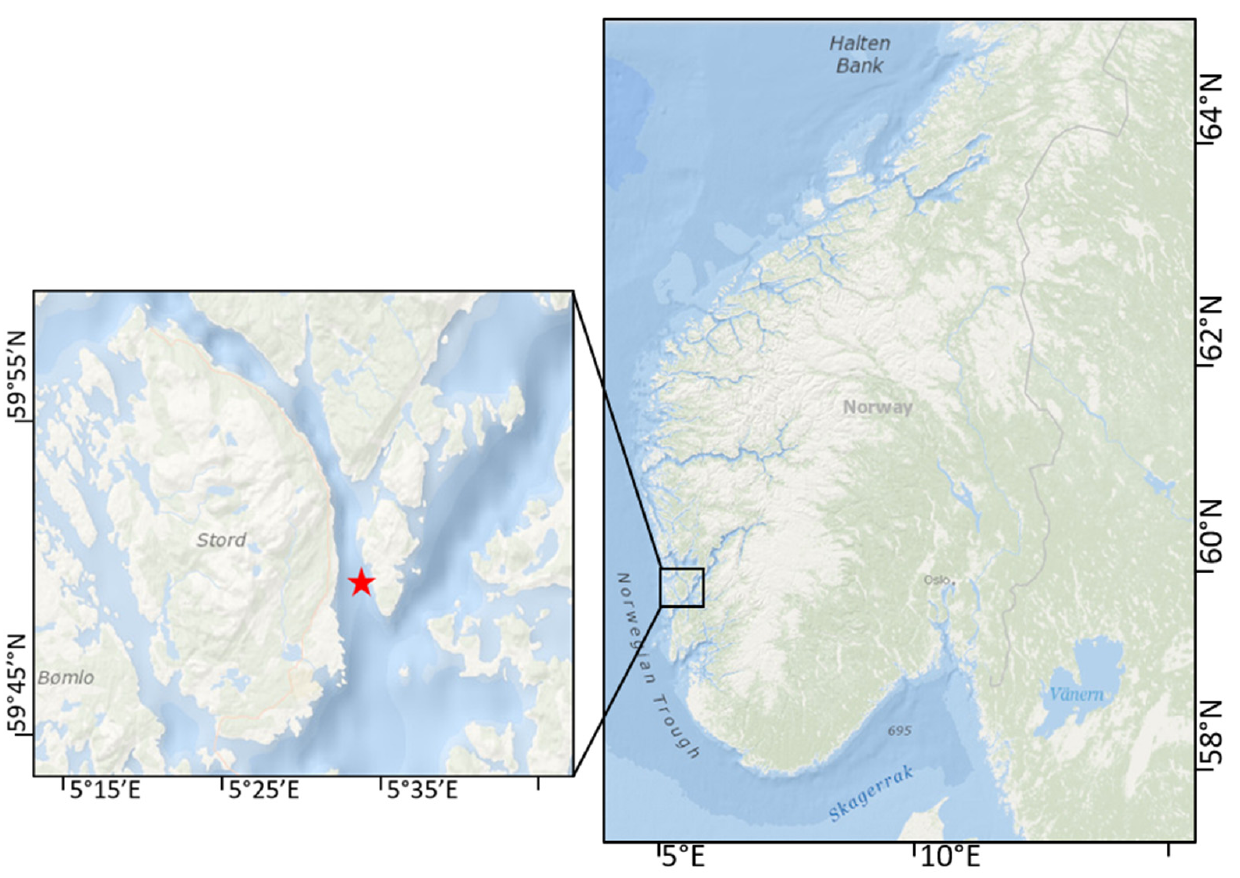
Figure 1. Nakken reef off the coast of Norway (59°49 ′ 49.1 ″ N, 5°33 ′ 22 ″ E; red star), a study area where Desmophyllum pertusum samples were collected from a depth of 200–220 m in 2016.